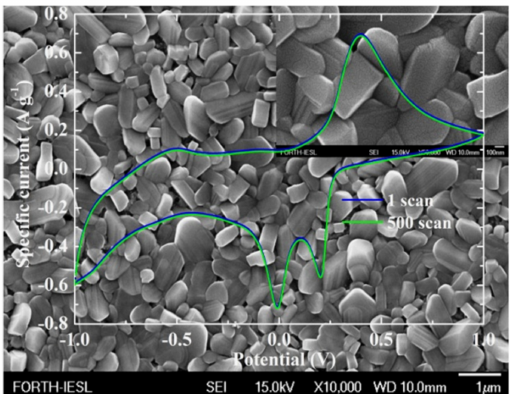
Figure 4. Cyclic voltammetry curves of the first and the 500th scan of the AACVD vanadate bronze for 15% Ag loading at 450 ◦ C on fluorine-doped SnO 2 precoated glass substrates overlapped on FE-SEM image (FE-SEM image for x50,000 as inset). The scan rate for the cyclic voltammetry curves was 10 mV s − 1